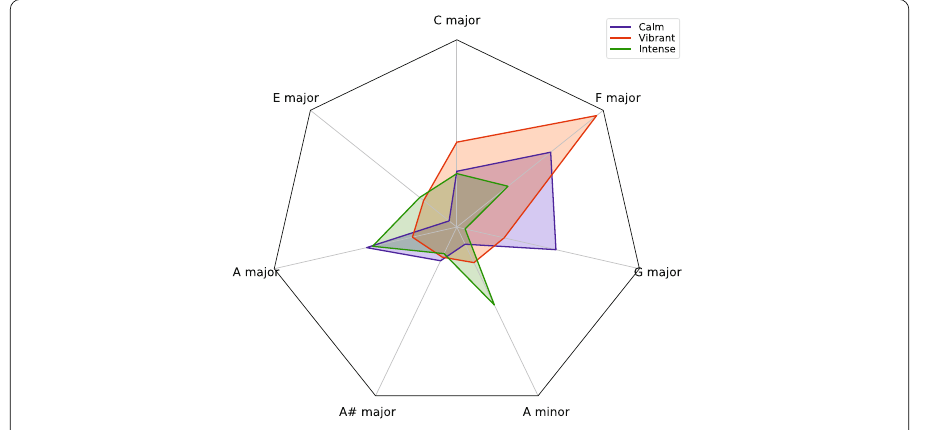
Figure 6 Most common music keys for the songs across the three music archetypes. Top-3 musical keys for the calm group are F Major, G Major, and A Major; top-3 musical keys for the vibrant group are F Major,